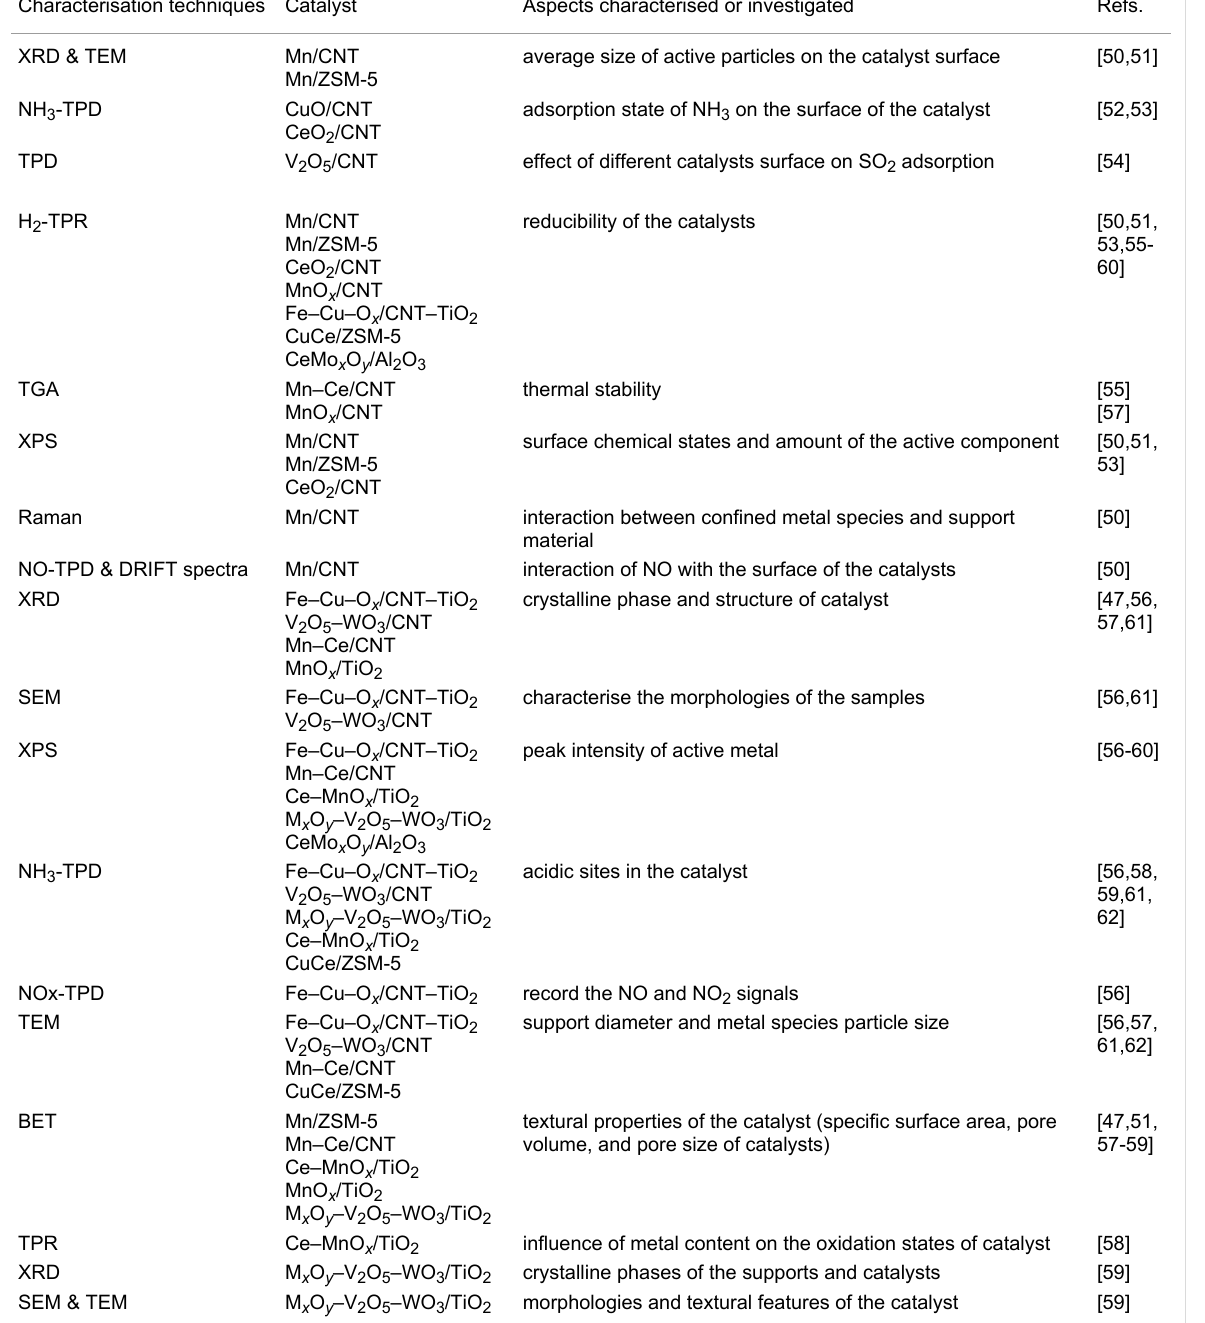
Table 1: Summary of typical characterisation approach for SCR-NH 3